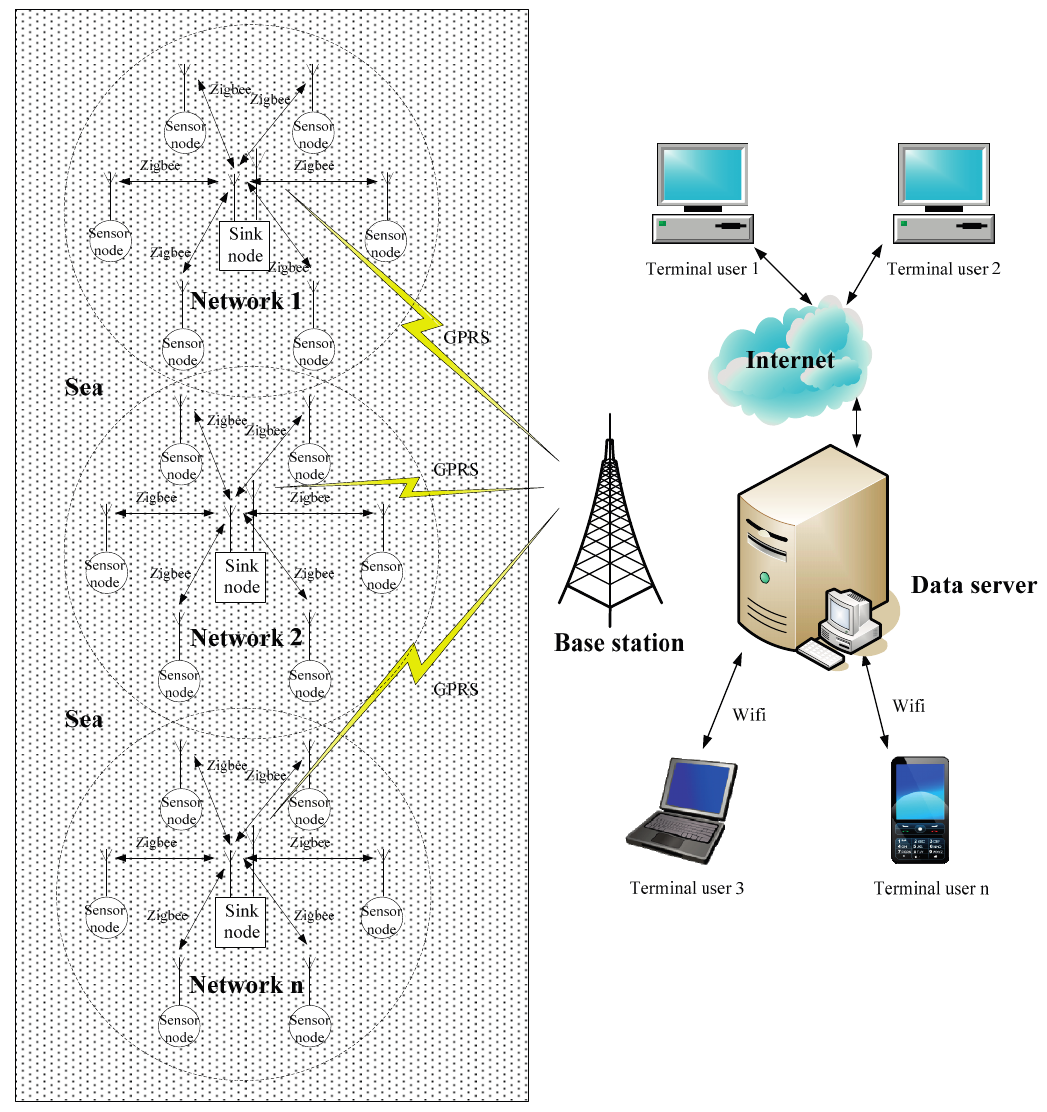
Figure 1. Common architecture of WSN-based marine monitoring